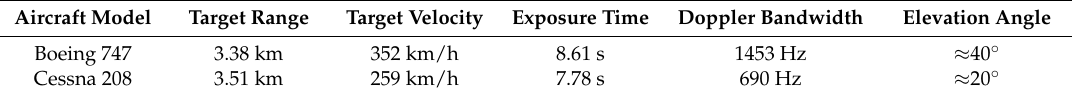
Table 2. Characteristics of the acquired ISAR data: Boeing 747 and Cessna 208.